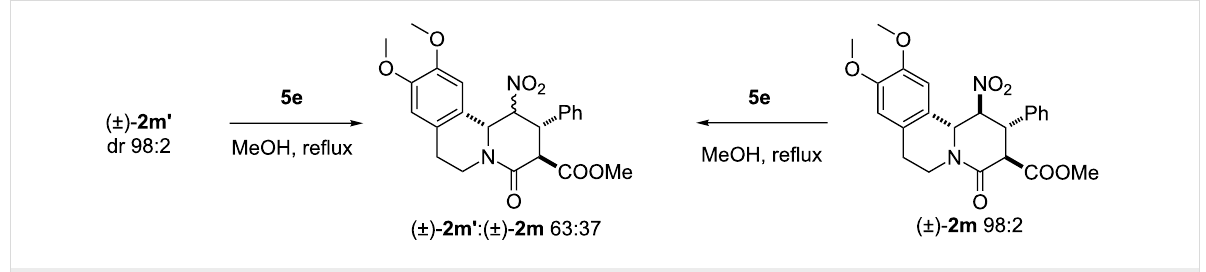
Scheme 7: Thermodynamically-driven epimerisation of 5-nitropiperidin-2-ones 2m and 2m’ .